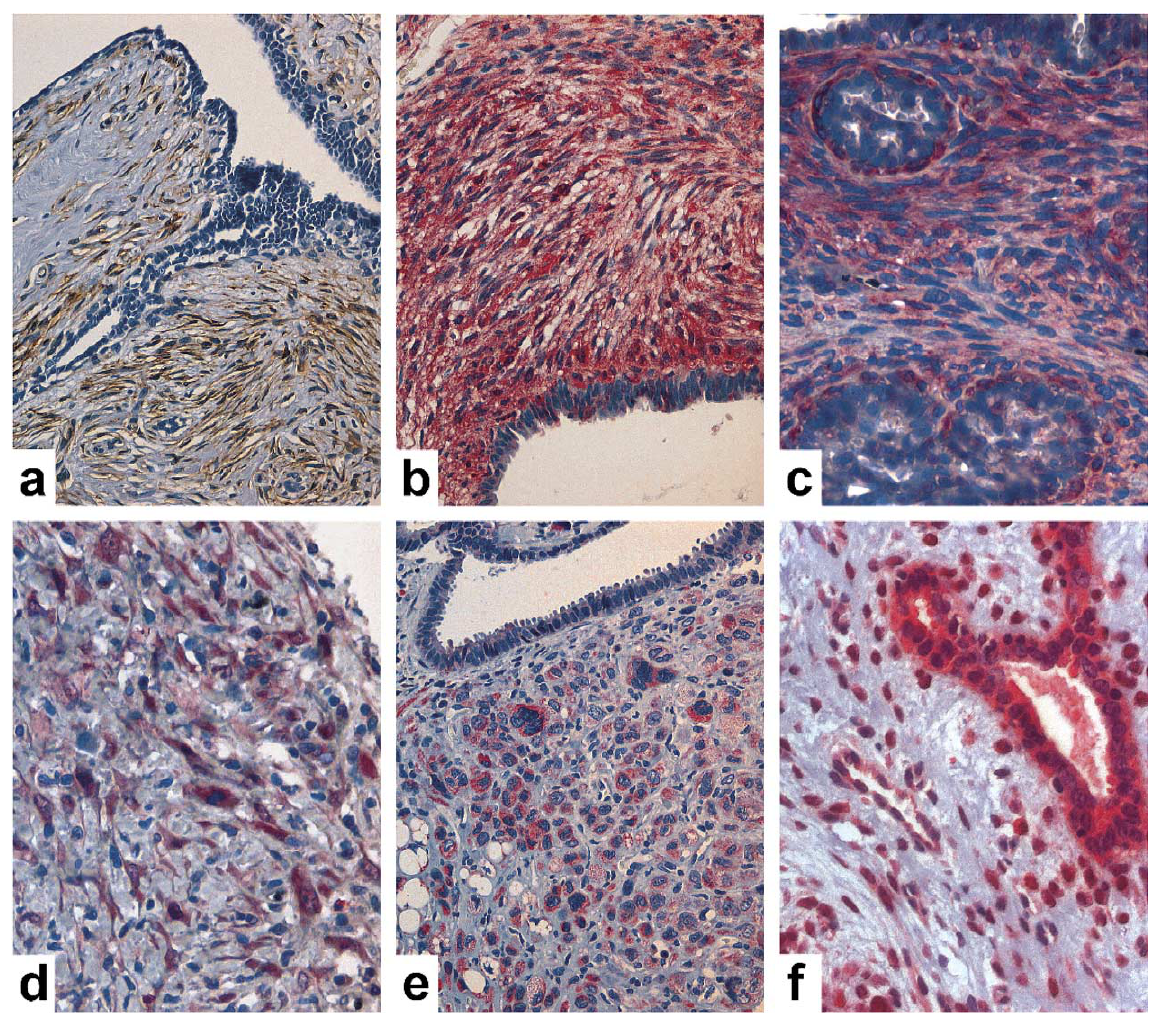
Fig. 1. Example of immunohistochemical staining patterns of caveolin-1 (a), eps15 (b), pERK (c), pAkt (d), EGF (e) and mdm2 (f) in phyllodes tumours of the breast. α expression was further significantly associated with tumour grade ( p < 0 .